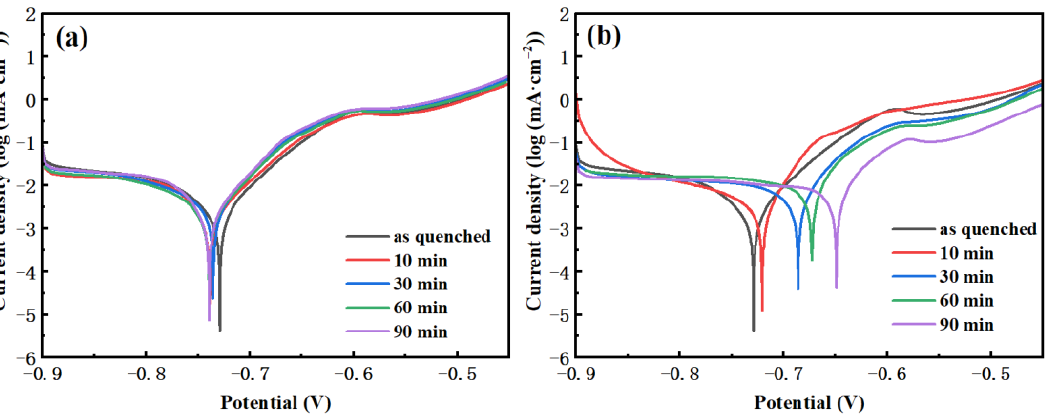
Figure 4. The polarization curves of FeCoSiBPC amorphous alloy at 280 °C; ( a ) vacuum; ( b ) non- vacuum.